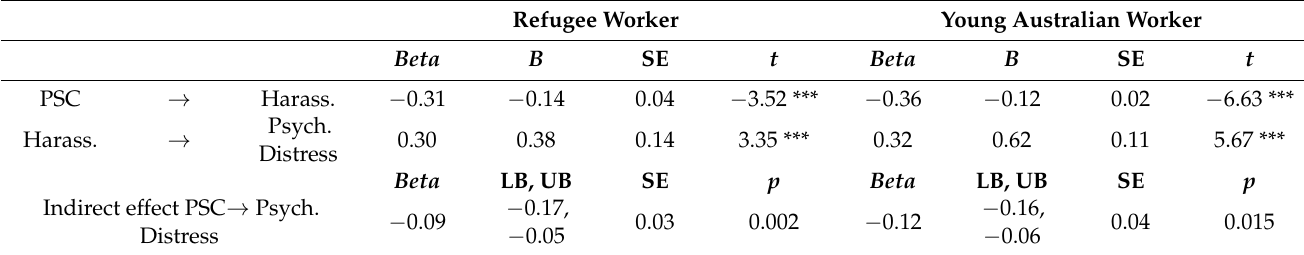
Table 6. Mediation